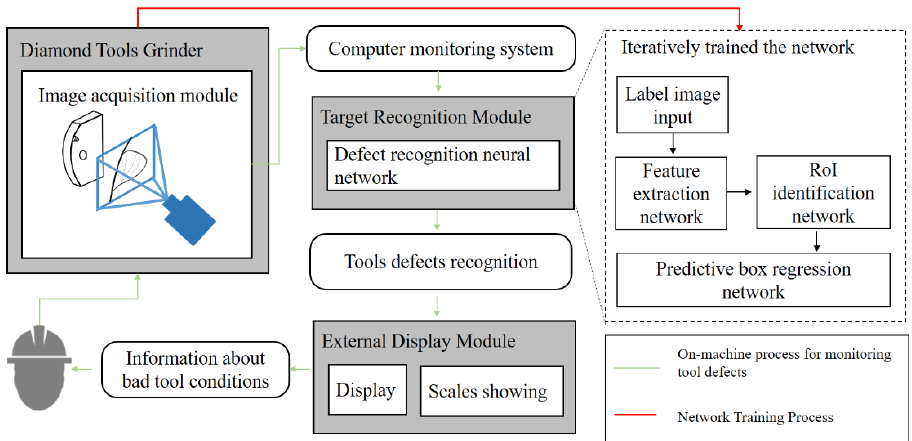
Figure 2. The overall process of defect identification in DToolnet.